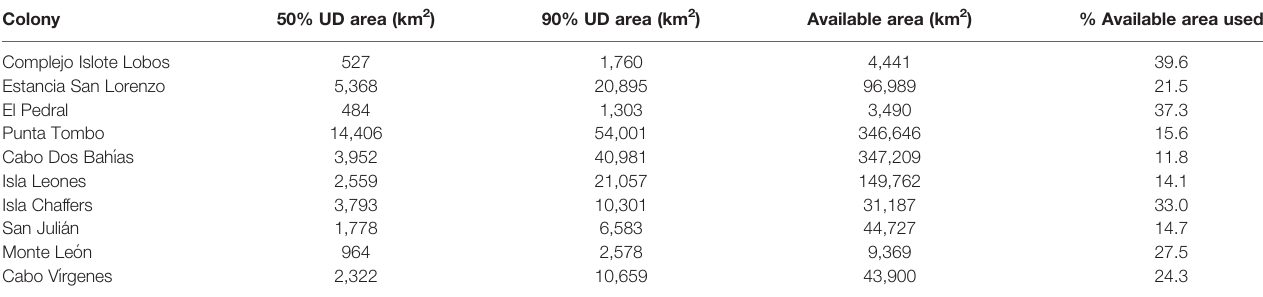
TABLE 5 | Foraging area used by Magellanic penguins from 10 colonies in Argentina.